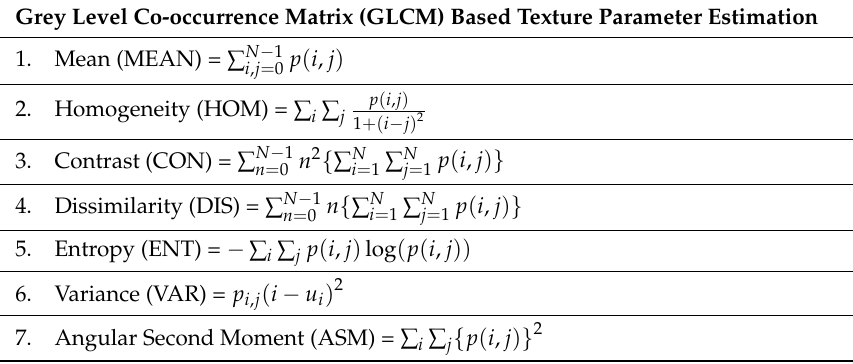
Table 3. Formulas for the texture measurements used in this study